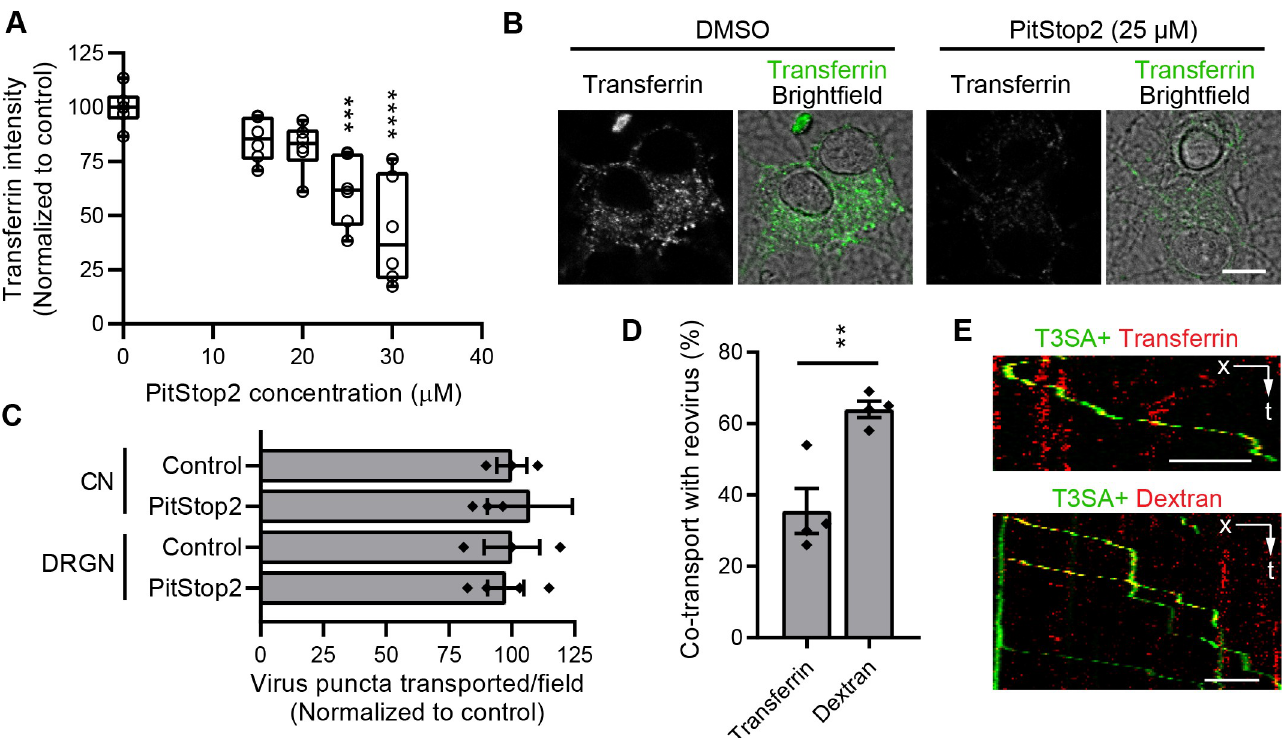
Fig 5. Clathrin-mediated endocytosis is not required for reovirus entry into neurons. (A) CNs were treated with PitStop2 at he concentrations shown, and the uptake of transferrin-Alexa Fluor 488 was quantified following treatment. Data are presented in a box plot with horizontal bars marking 25 th and 75 th percentiles and median values, and the whiskers marking extreme values. Individual data points represent means normalized to DMSO-treated controls from three independent experiments, each with duplicate samples. Values that differ significantly from control by ANOVA and Dunnett’s test are indicated ( ��� , P < 0.001; ���� , P < 0.0001). (B) Representative micrographs show reduced uptake of transferrin following treatment with 25 μ m PitStop2 compared with a DMSO-treated control. Scale bar, 10 μ m. (C) CNs or DRGNs were treated with 25 μ m PitStop2 (Table 1), and T3SA+ puncta transported per field-of-view were enumerated following treatment. Bars indicate means of four samples normalized to DMSO-treated control. Error bars indicate SEM. Individual data points are averages from 8 to 12 fields-of-view per sample. Values did not differ significantly from control as determined by t -test ( P > 0.05). (D-E) CNs were incubated with fluorescently- labeled transferrin or dextran (10 kDa) and T3SA+ virions. The percentage of reovirus puncta that co-traffic with transferrin or dextran is shown (D) along with representative kymographs (E). �� , P < 0.01 determined by t -test. Bars indicate means of duplicate samples from two independent experiments. Error bars indicate SEM. Individual data points represent averages from 8 to 12 fields-of-view from each sample ( n = 184 and 335 reovirus puncta analyzed for co-transport with transferrin and dextran, respectively). Scale bar, 5 μ m.